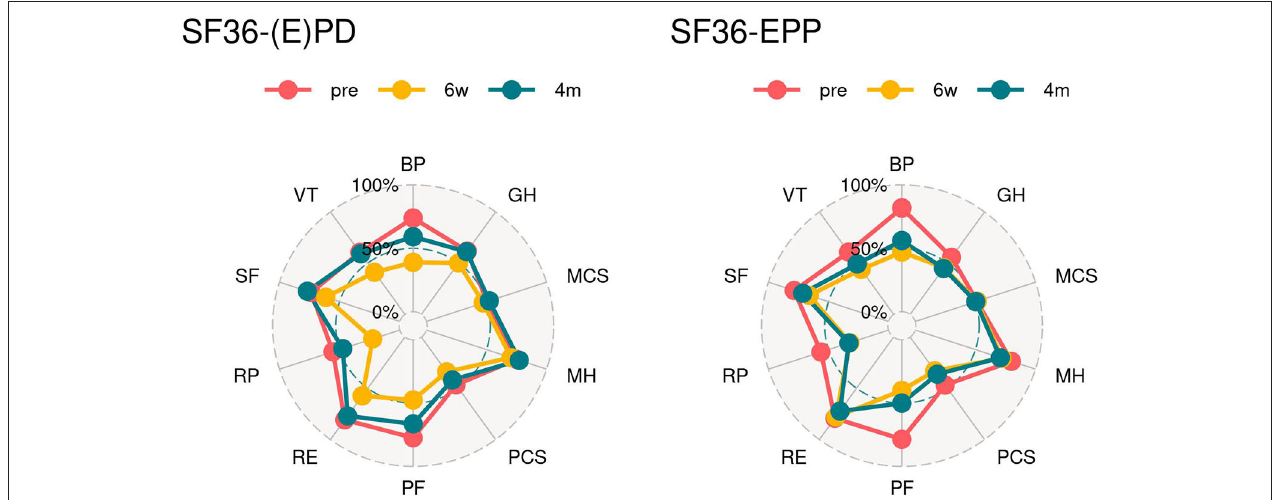
FIGURE 2 | Spider graphs. SF 36 (1986): score of zero is equivalent to maximum disability and a score of 100 is equivalent to no disability. PF, physical functioning; RP, role physical; BP, bodily pain; GH, global health; VT, vitality; SF, social functioning; RE, role emotional; MH, mental health; PCS, physical component summary; MCS, mental component